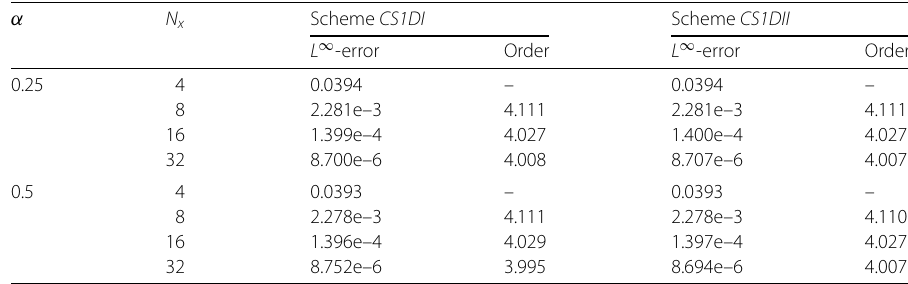
Table 1 Numerical comparison results of schemes CS1DI and CS1DII for Example 1, at T = 1 with N = 1000 and different N x and α α N x Scheme